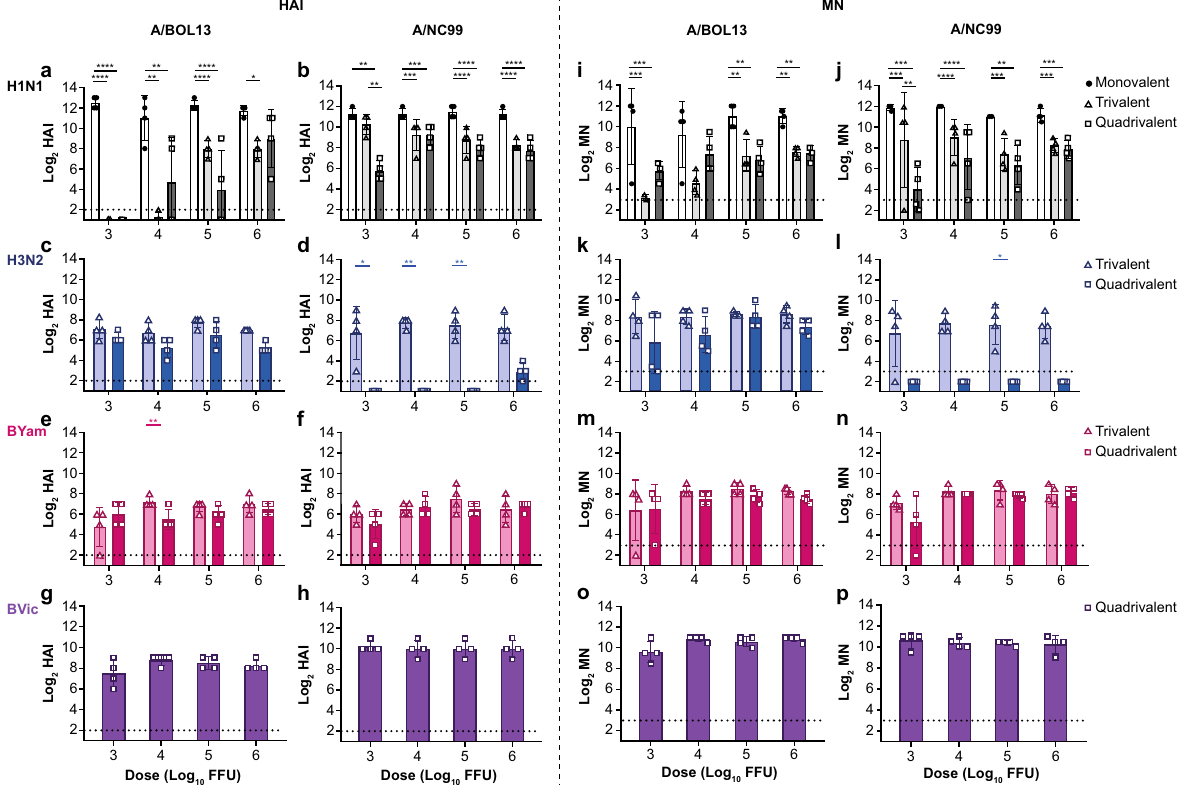
Fig. 3 A/BOL13 serum immune responses are more strongly reduced in multivalent formulations. Serum immune responses were measured by HAI and MN assays at Days 7, 14, 21, and 27 post-vaccination. Representative data from Day 21 are shown. a , b HAI and MN data for all strains in A/BOL13 containing formulations. HAI — a (A/BOL13); c (A/SWITZ13); e (B/PHUK13); g (B/BRIS08). MN — b (A/BOL13); d (A/SWITZ13); f (B/PHUK13); h (B/BRIS08). i – p HAI and MN data for all strains in A/NC99 containing formulations. HAI — i (A/NC99); k (A/SWITZ13); m (B/PHUK13); o (B/BRIS08). MN — j (A/NC99); l (A/SWITZ13); n (B/PHUK13); p (B/BRIS08). Bar graphs show geometric mean log 2 titers for individual animals (symbols), 4 animals per dose group. Columns and error bars show group geometric mean and group geometric standard deviation. Statistical comparison in all cases was performed by two-way analysis of variance with Sidak ’ s post-test correcting for multiple comparisons.* P < 0.05, ** P < 0.01, *** P < 0.001, **** P < 0.0001. Dotted lines indicate lower limit of detection; values below this were plotted as 0.5× the lower limit of detection. A/BOL13 A/Bolivia/559/2013, A/NC99 A/New Caledonia/20/1999, A/SWITZ13 A/Switzerland/ 9715293/2013, B/PHUK13 B/Phuket/3073/2013, B/BRIS08 B/Brisbane/60/2008, FFU fl uorescent focus units, HAI hemagglutination inhibition, MN log 10 FFU-vaccinated animals. This indicated that A/BOL13 was able to produce comparable serum antibody responses to A/NC99 in MLAIV-responding animals but suffered a distinct reduction in serum immune responses in multivalent formulations, most notably at the lowest 3.0 and 4.0 log 10 FFU vaccine doses. A/ NC99 was considerably less affected. In A/BOL13 formulations, H3N2 A/SWITZ13 serum antibody responses were consistent across the dose range by both HAI and